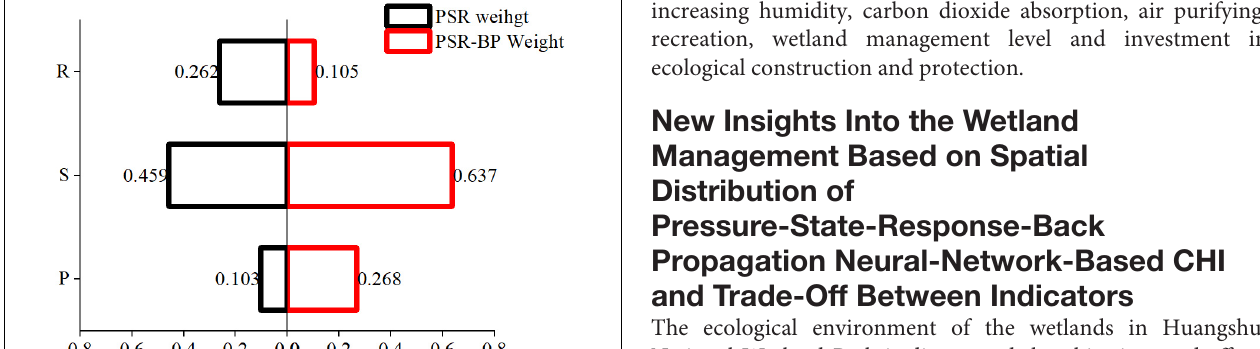
FIGURE 6 | Comprehensive score of health evaluation index of urban wetland. The black trend line A represents the health score of the Huangshui wetland obtained from the PRS-BP neural network model. The red trend line B represents the health score of the Huangshui wetland obtained from the ordinary PRS model. P (Pressure); S (State); R